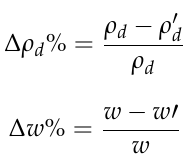
Figure 8. Statistical result chart of the relative error frequency of water content of M1. Table 8. Statistical results of the relative error frequencies of dry density and water content of M1. Model No.